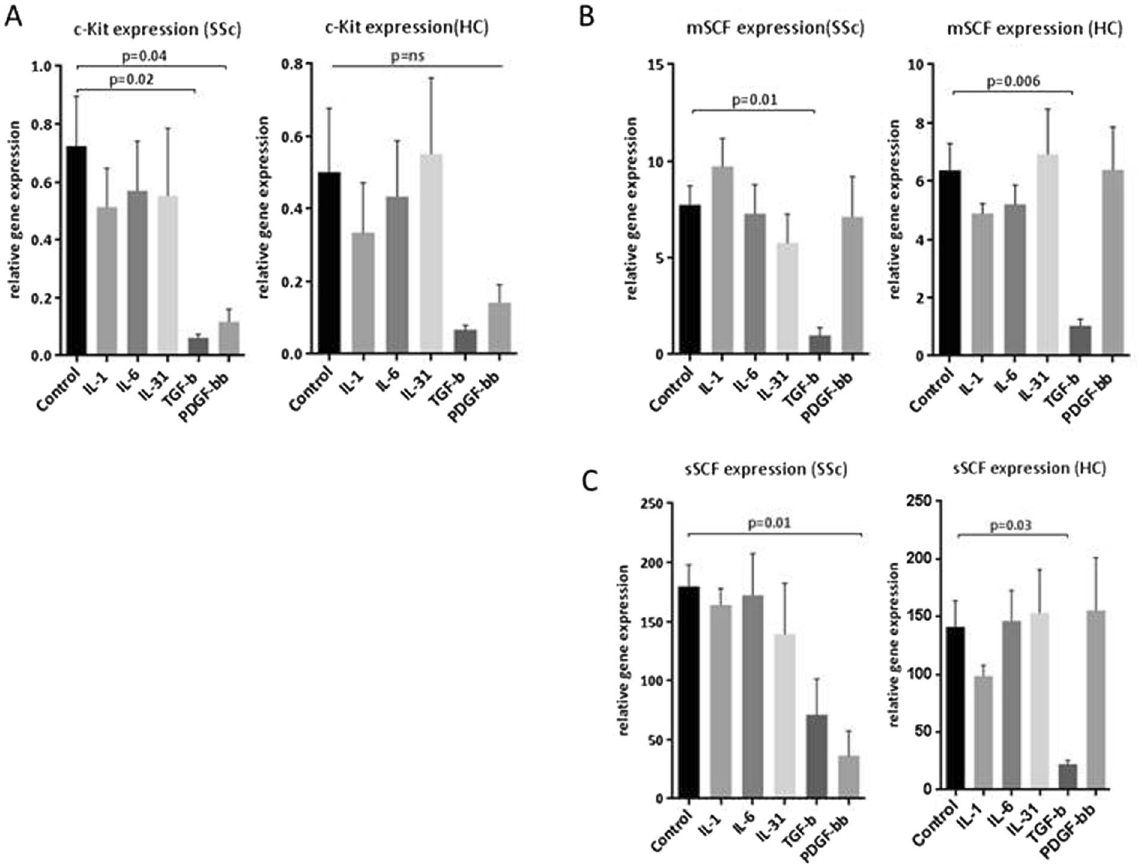
Figure 6. Regulation of SCF/c-Kit in lung fibroblasts by candidate cytokines and growth factors. SSc and control lung fibroblasts (n = 4 cell lines for both) were cultured in 6 well plates, switched overnight to serum free conditons, and then cultured for a further 24 hours with or withut candidate cyctokines and growth factors as shown. Cells were lysed and SCF/c-Kit assayed by qPCR. Gene expression of c-Kit was unaltered by inflammatory cytokines but greatly reduced by TGF β and PDGF-BB, significant in SSc cells ( A ). Intriguingly, TGF β , considered an important agonist in fibrotic disorders, also greatly inhibited both isoforms of SCF, whereas PDGF led to suppression of full length SCF in SSc cells only ( B , C